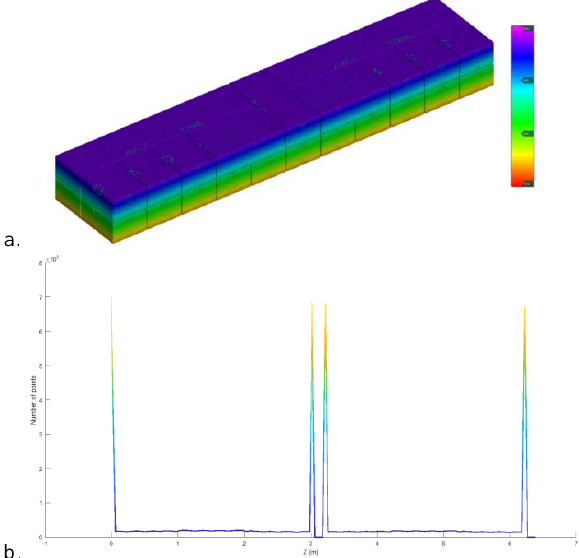
Figure 2. Synthetic point cloud used as a reference dataset to test the presented methodology (a); and point cloud density distribution in vertical direction